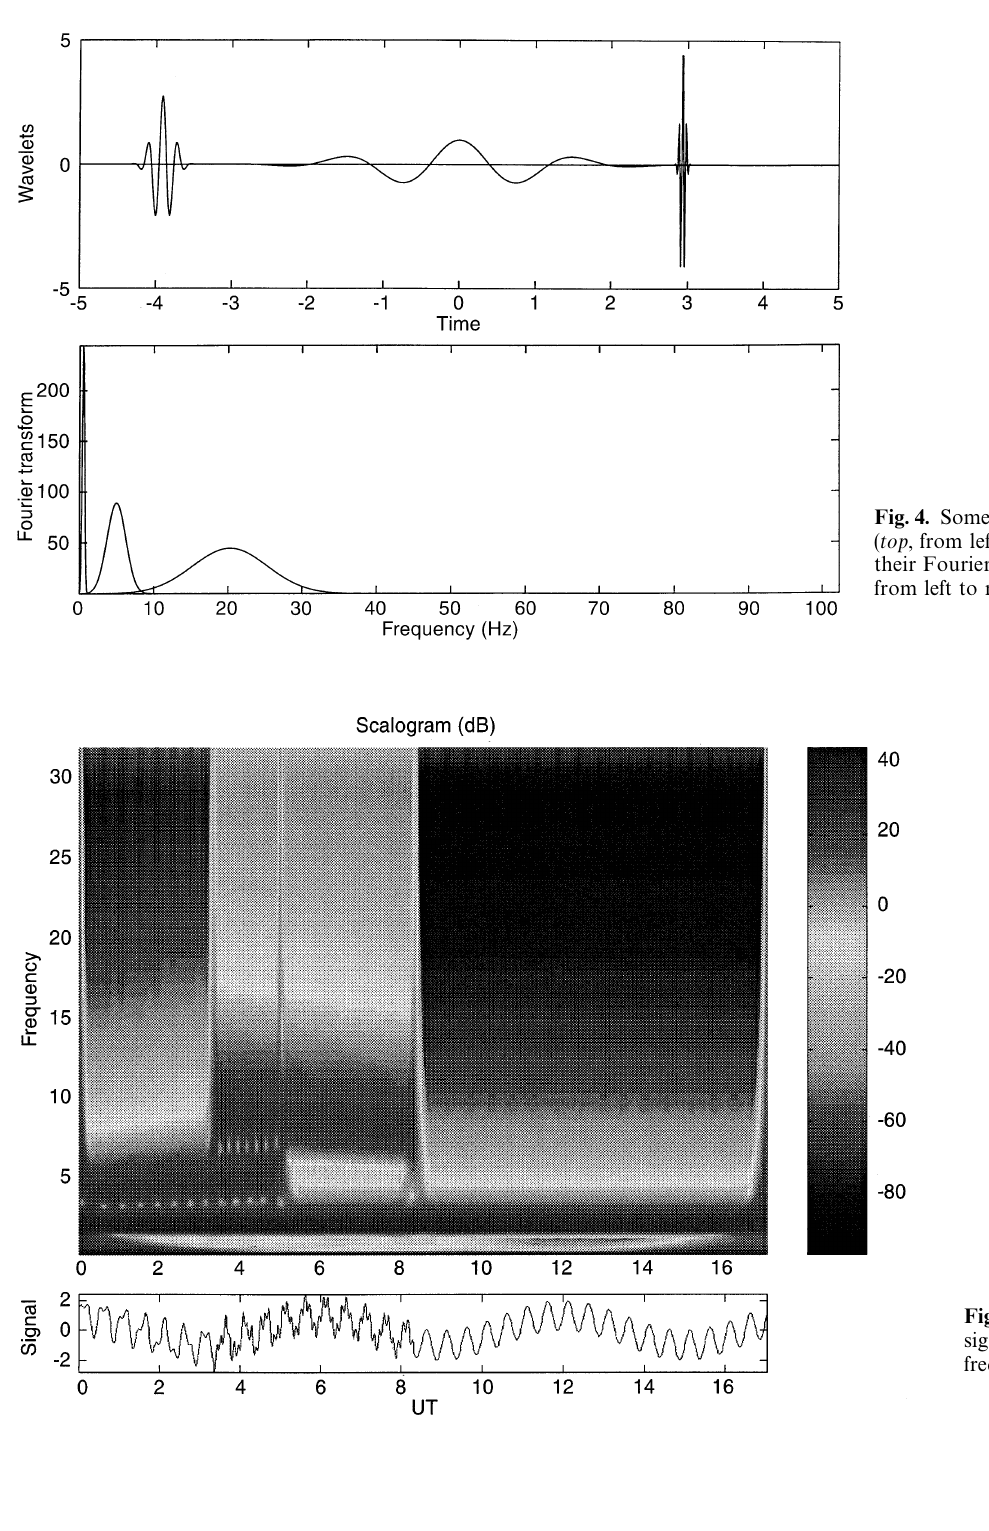
Fig. 5. Scalogram of the synthetic signal in the noise-free case; frequencies are in h (cid:126)(cid:49)